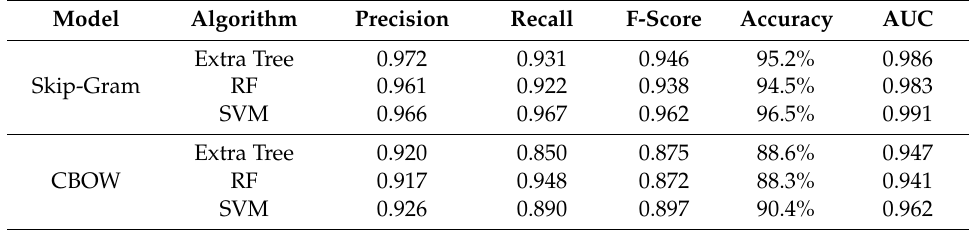
Table 9. Summary for classification algorithms with the entity embedding model on the test